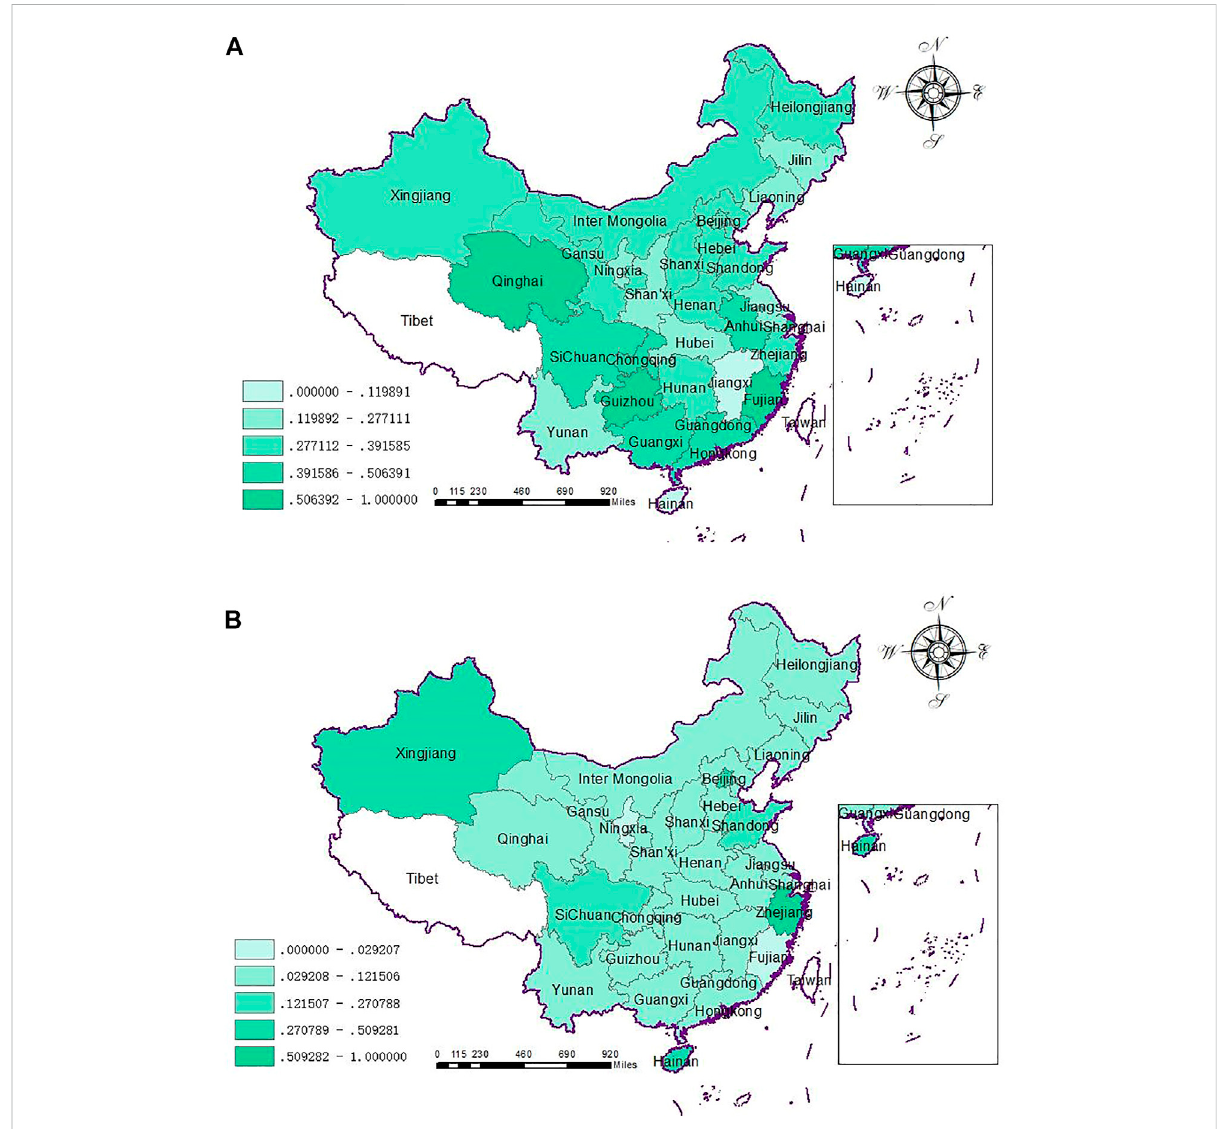
FIGURE 1 Degrees of regional GVC embeddedness in China in (A) 2000 and (B)